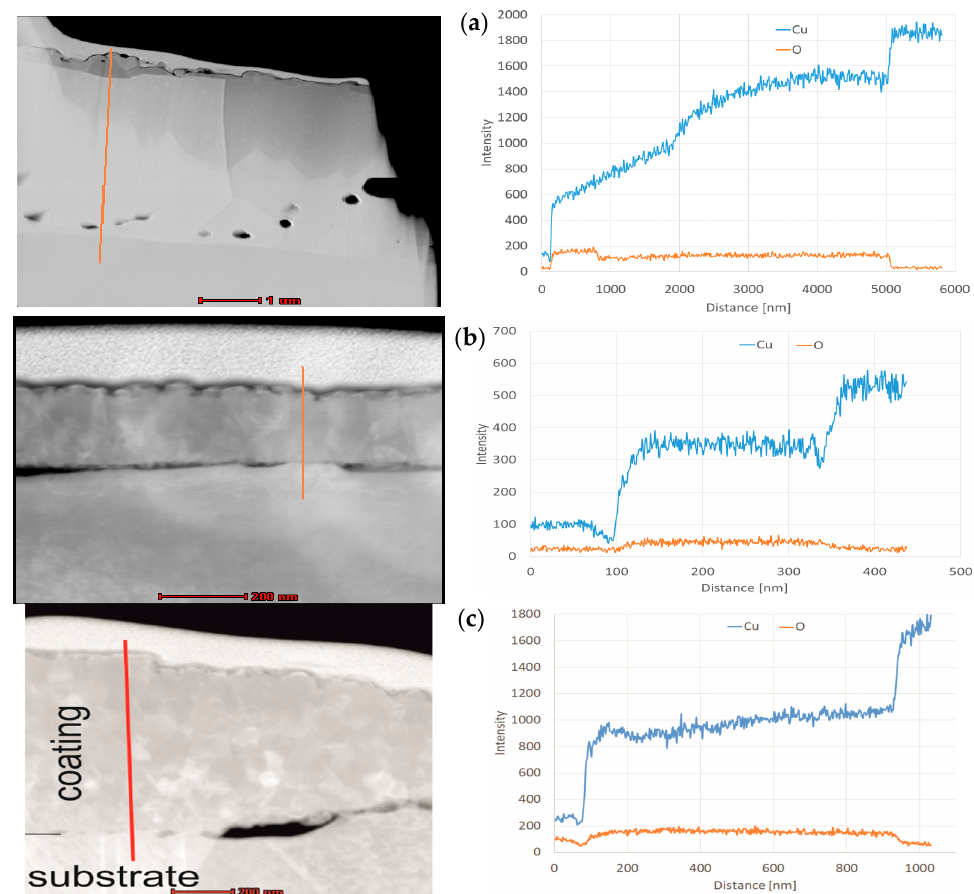
Figure 8. Linear change in X-ray intensity for individual elements: ( a ) L1-1 (made with diode laser), ( b ) L2-4 (made with disc laser), and ( c ) L3-1 (made with IR furnace).